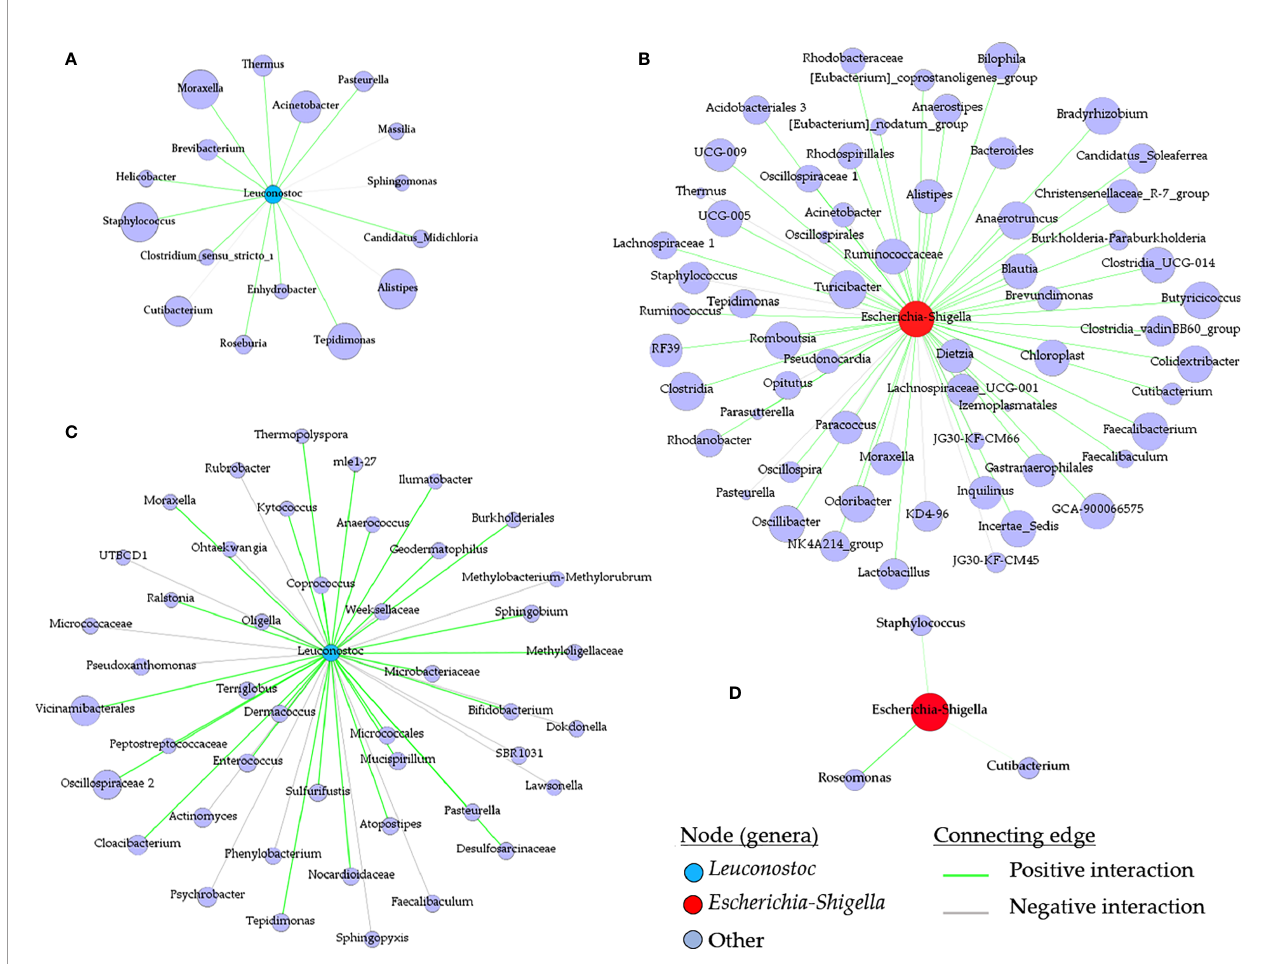
FIGURE 6 | Local connectivity of Leuconostoc and Escherichia - Shigella in the co-occurrence networks. The nodes/taxa linked to Leuconostoc (cyan node, A, C ) and Escherichia - Shigella (red node, B, D ) were identi fi ed in the bacterial co-occurrence networks of ticks fed on mock-immunized (A, B) , L. mesenteroides - immunized (C) and E. coli -immunized (D) mice. Connecting edges with positive and negative interactions were also identi fi